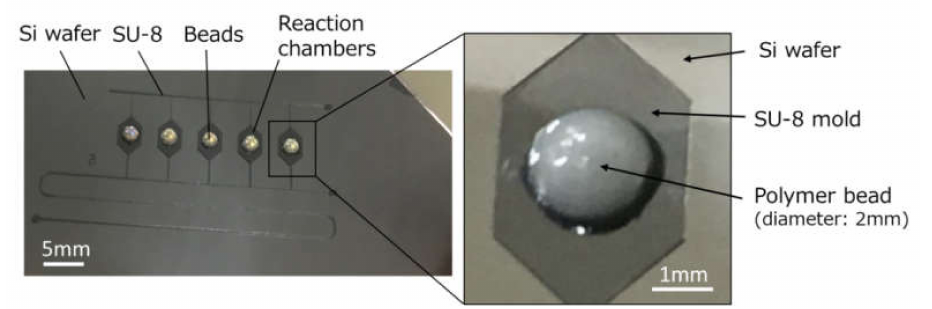
Figure 4. Photographs of an SU-8 master mold pattern on an Si wafer, in which hemispherical polymer beads (2 mm in diameter) were bonded with epoxy adhesive on the surface of five microchamber patterns to create deep localized structures, after replicating this mold in